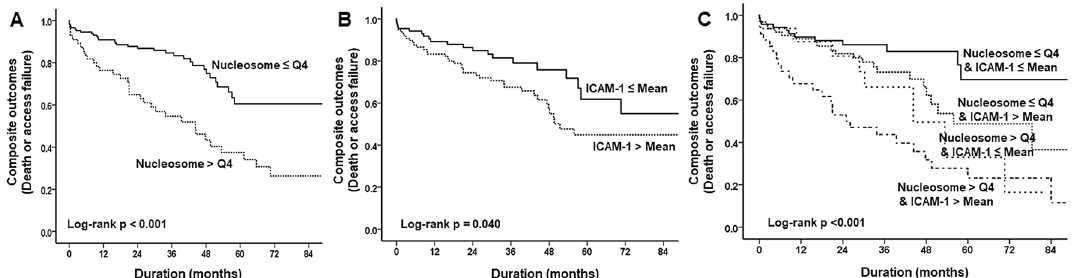
Figure 2. Survival analysis based on nucleosome and ICAM-1 levels. Kaplan–Meier survival curves based on nucleosome level of Q4 and Q1-3, and mean ICAM-1 level ( A , B ). A significant difference was observed between the two curves. Patients in nucleosome Q4 and a high ICAM-1 level showed the worst prognosis ( C